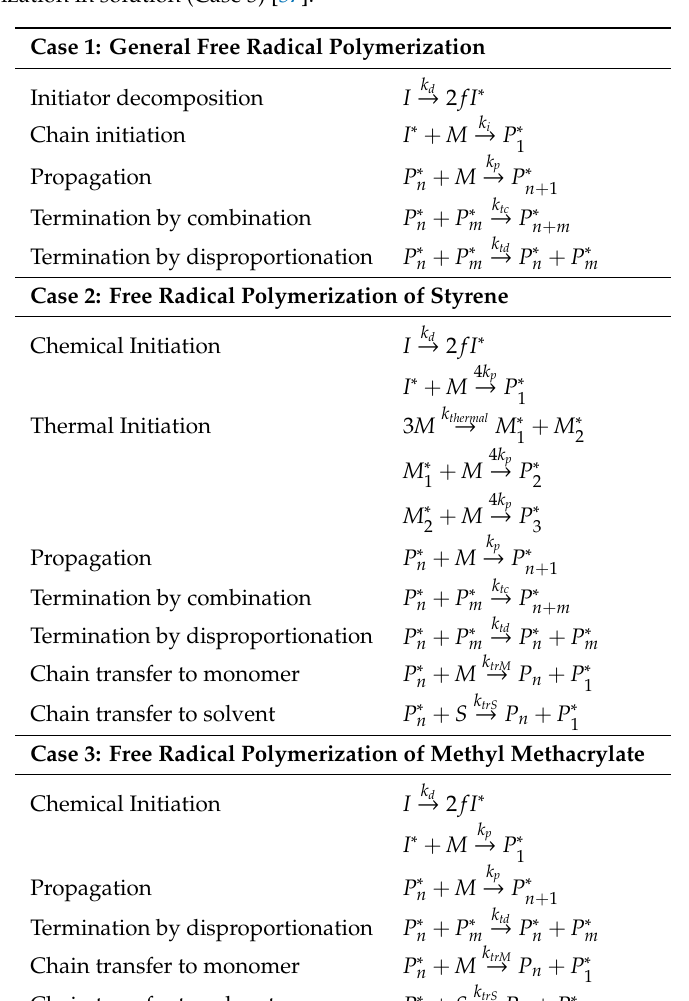
Table 1. Elementary reactions in the cases considered in this work: general free radical polymerization (Case 1), styrene free radical polymerization in solution (Case 2) [36], and methyl methacrylate free radical polymerization in solution (Case 3)